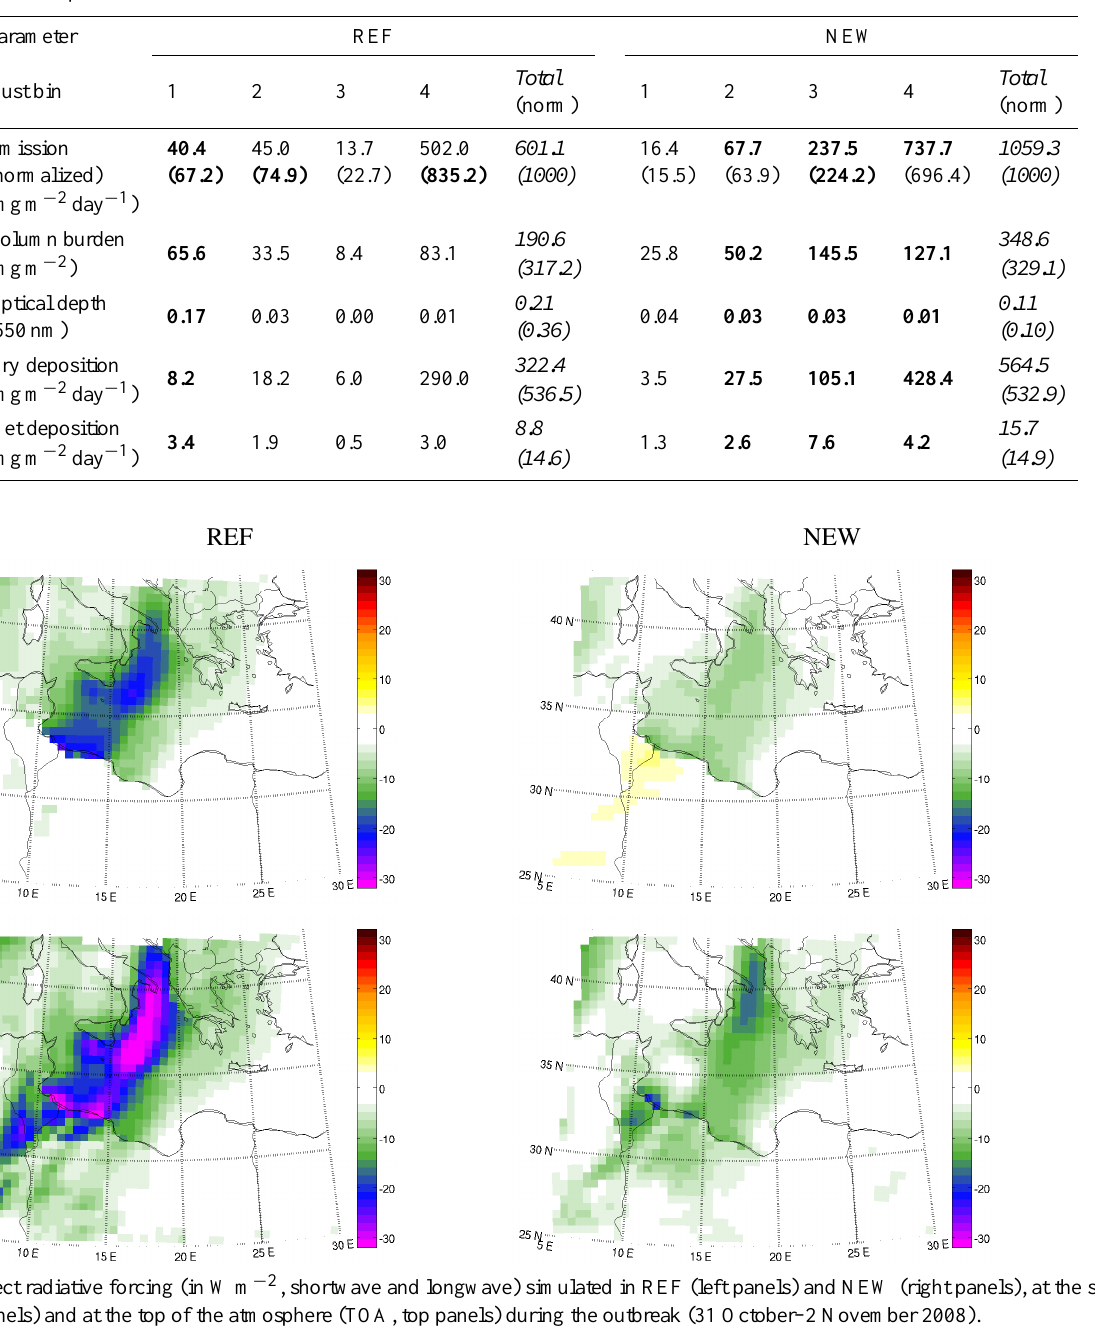
Table 2. Average dust emission, integrated concentration and optical depth (550nm) and deposition during the outbreak (23–25 March 2008) over the affected zone (25–48 ◦ N, 6–45 ◦ E) for each dust bin. 1: 0.01–1.0µm, 2: 1.0–2.5µm, 3: 2.5–5.0µm, 4: 5.0–20.0µm. The largest value for each bin is indicated in boldface. The normalized value (for a total emission of 1000mgm − 2 day − 1 ) of each term is indicated between brackets, and in a specific line for the emission of each bin.